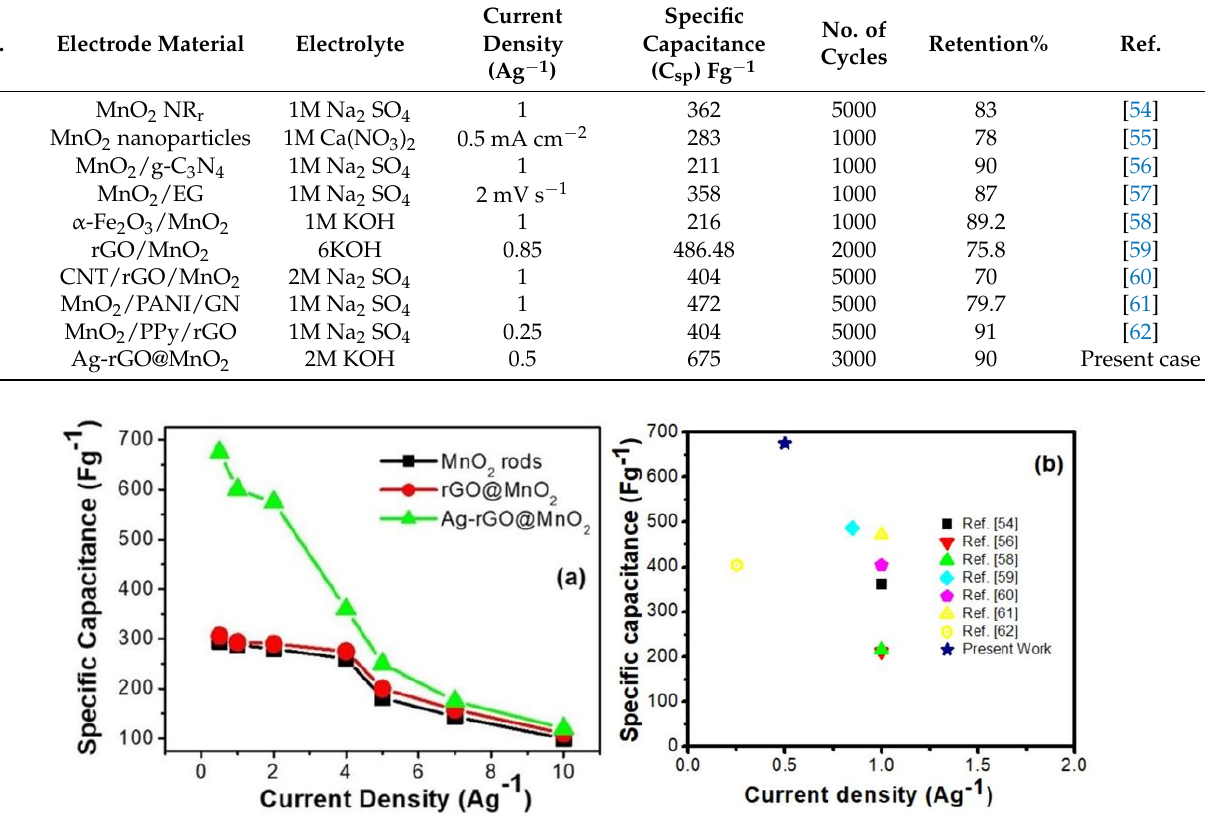
Figure 11. ( a ) Calculated specific capacitance versus current density plot of prepared electrode based on pure MnO 2 rods and their composites, ( b ) comparative specific capacitance graph of MnO 2 -based nanocomposites in further published papers.